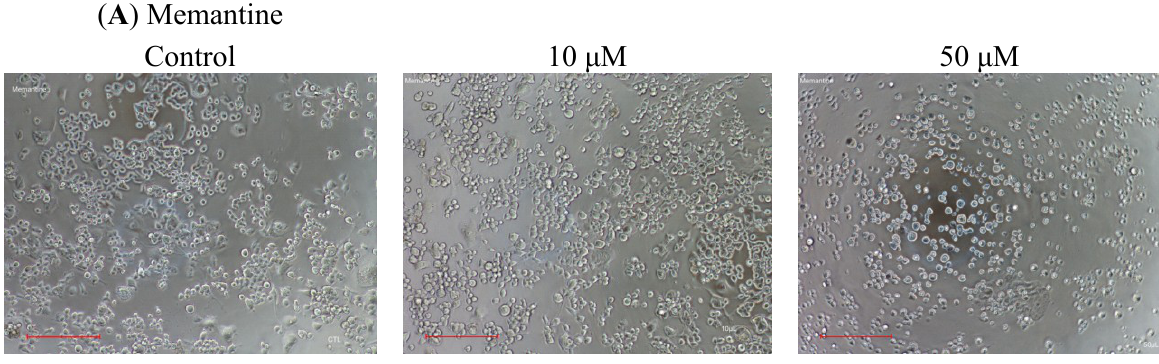
Figure 5. Macrographs using phase contrast microscopy of single point screen at 10 and 50 μM of test compound on N2a